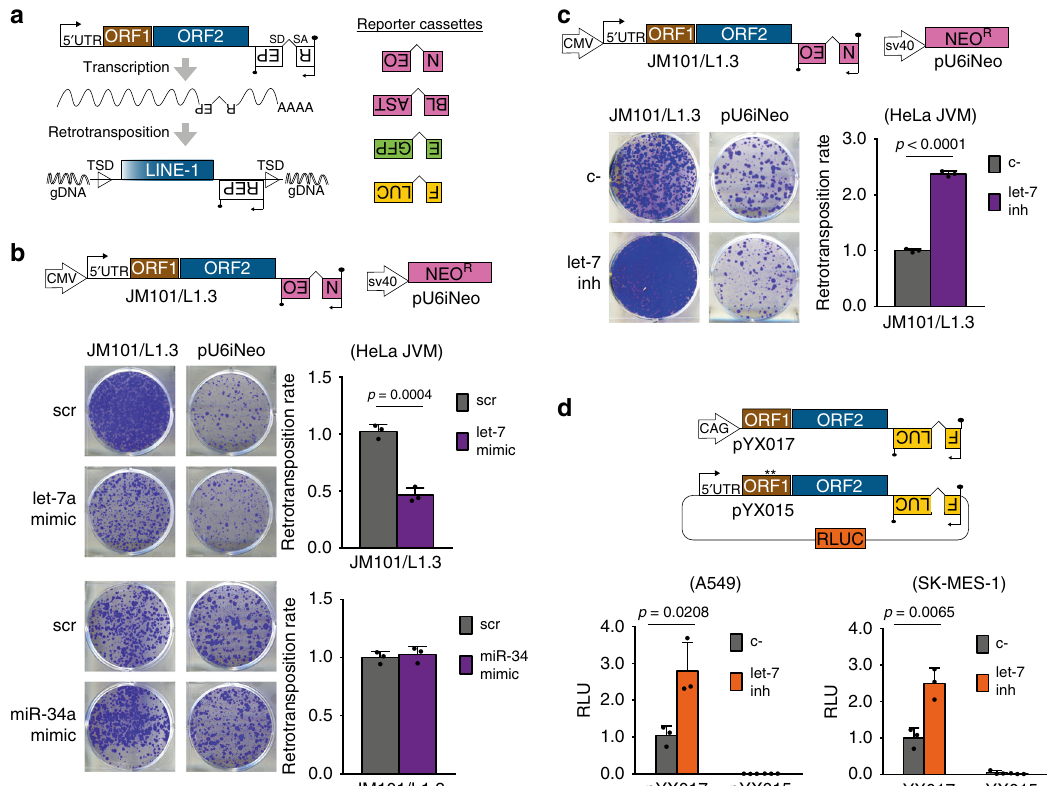
Fig. 2 Let-7 regulates engineered human LINE-1 retrotransposition. a Left panel: rationale of the retrotransposition assay in cultured cells. From left to right: transcription start site in the 5 ′ UTR (black arrow), the two L1 open reading frames ORF1 (brown rectangle) and ORF2 (blue rectangle), the antisense- oriented reporter cassette (white rectangles, backward REP) interrupted by an intron, and the reporter gene promoter (inverted black arrow). Black lollipops represent poly(A) signals. TSD: Target Site Duplications. SD: Splicing Donor. SA: Splicing Acceptor. Right panel: reporter cassettes used in this study: neomycin (NEO or mneoI ) and blasticidin (BLAST or mblastI ) resistance, enhanced green fl uorescent protein (EGFP or megfpI ), and fi re fl y luciferase (FLUC or m fl ucI ). b , c Structures of pJM101/L1.3 and pU6iNeo constructs are shown. b HeLa cells were co-transfected with one of the plasmids and